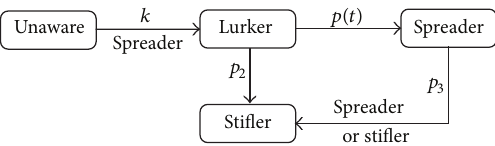
Figure 4: Structure of rumor spreading